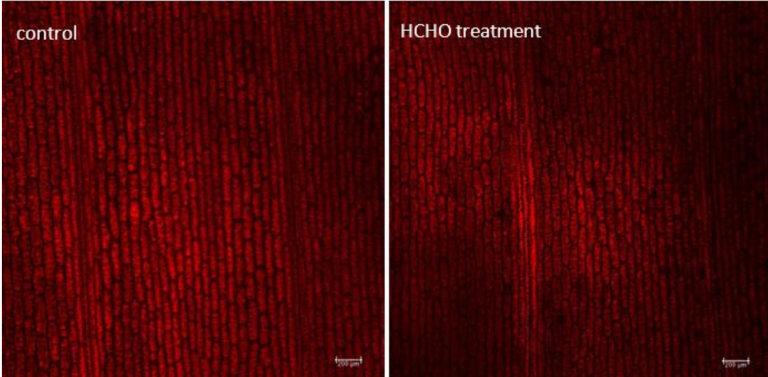
Figure 4. Effect of treatment with gaseous formaldehyde applied in a dose of 20 mg m − 3 on the intensity of chlorophyll fluorescence in C. comosum leaf tissue after 48 h of plant exposure.